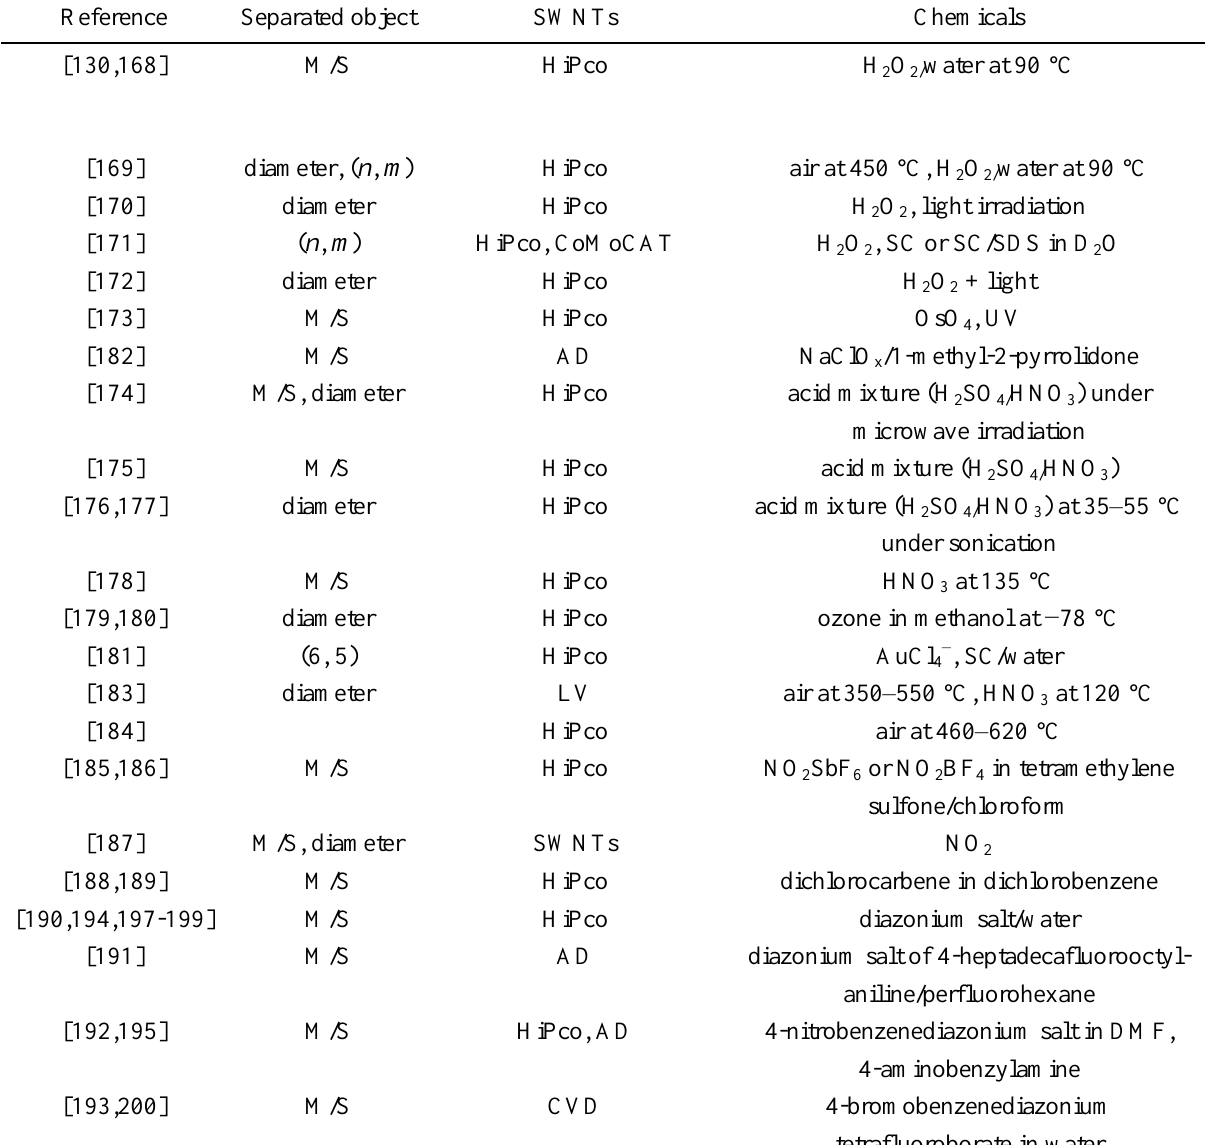
Table 5. Separation of SWNTs by selective